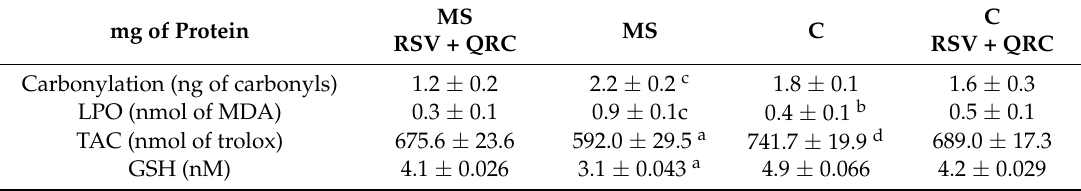
Table 2. Effect of Resveratrol and Quercetin administration on oxidative stress markers. MS mg of Protein RSV +